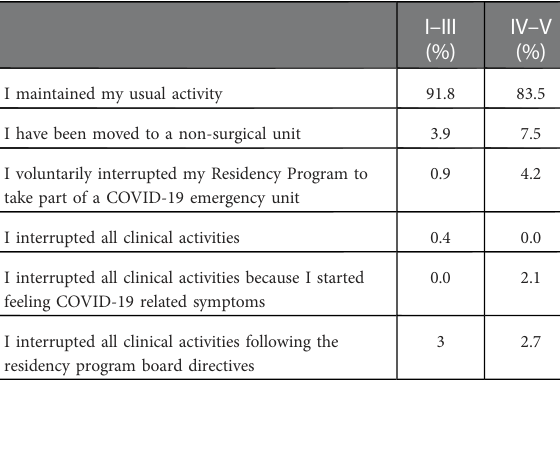
Impact of COVID-19 second wave on surgical activities (381)